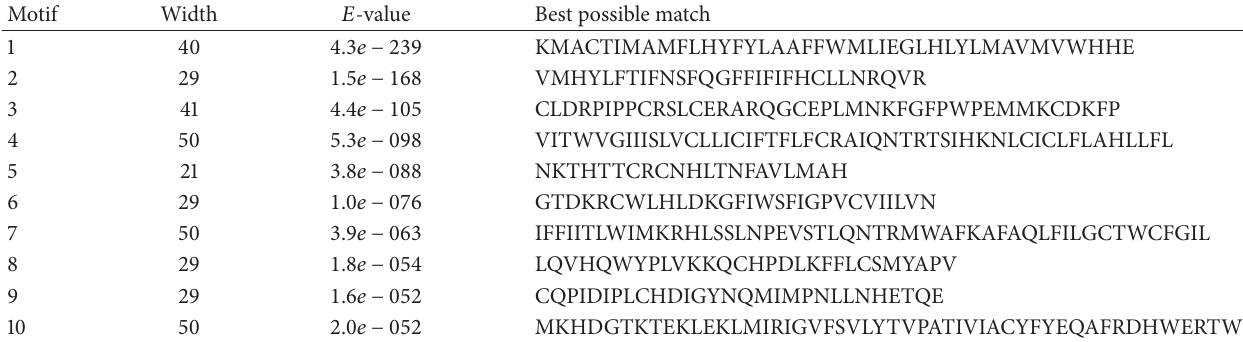
Table 6: Human top 10 conserved motifs of GPCR sequences found by the MEME